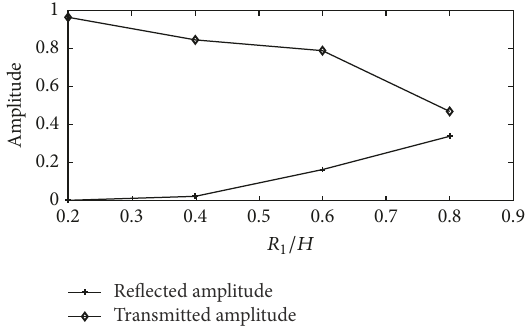
Figure 8: Reflected and transmitted amplitudes due to a defect at the bonding